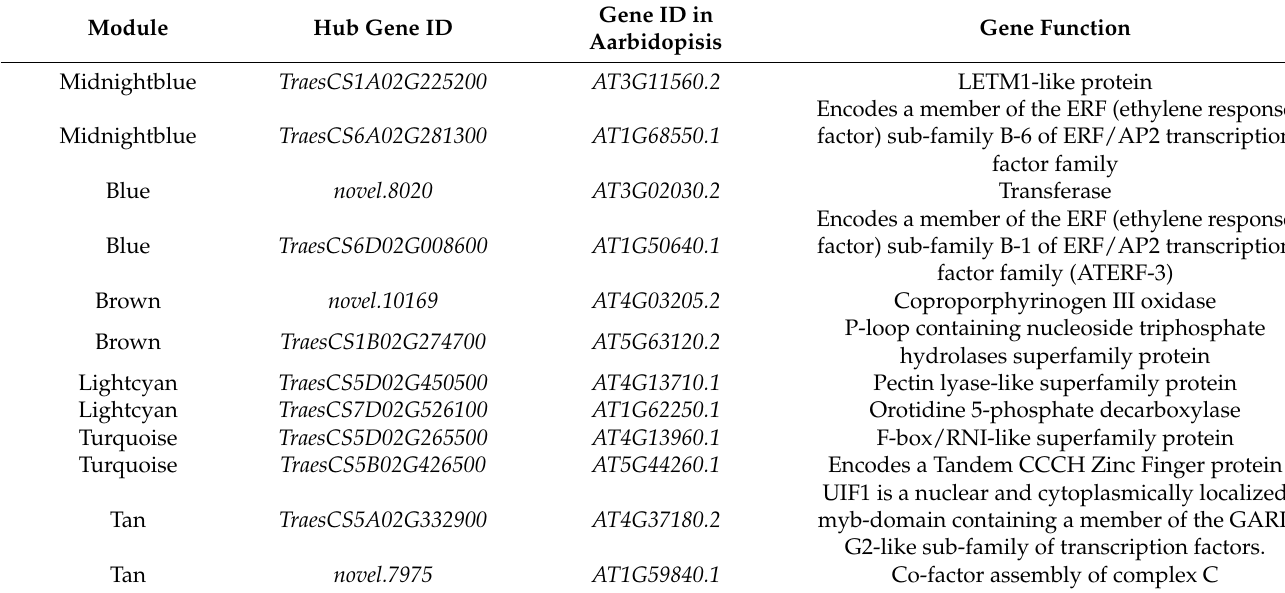
Table 1. Functional prediction of hub